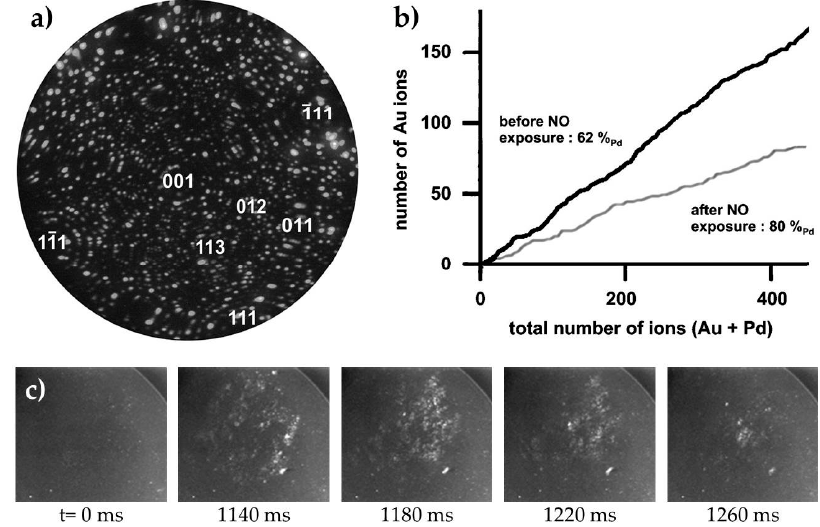
Figure 18. Study of Au-Pd alloy by field emission techniques: ( a ) FIM image of Au-Pd alloy (Au-62 at% Pd). The main discernable crystallographic orientations are represented by their Miller indexes. Conditions of acquisition: T = 45 K, P Ne = 10 − 3 Pa, F = 3.5 V/Å; ( b ) Cumulative plots of ions